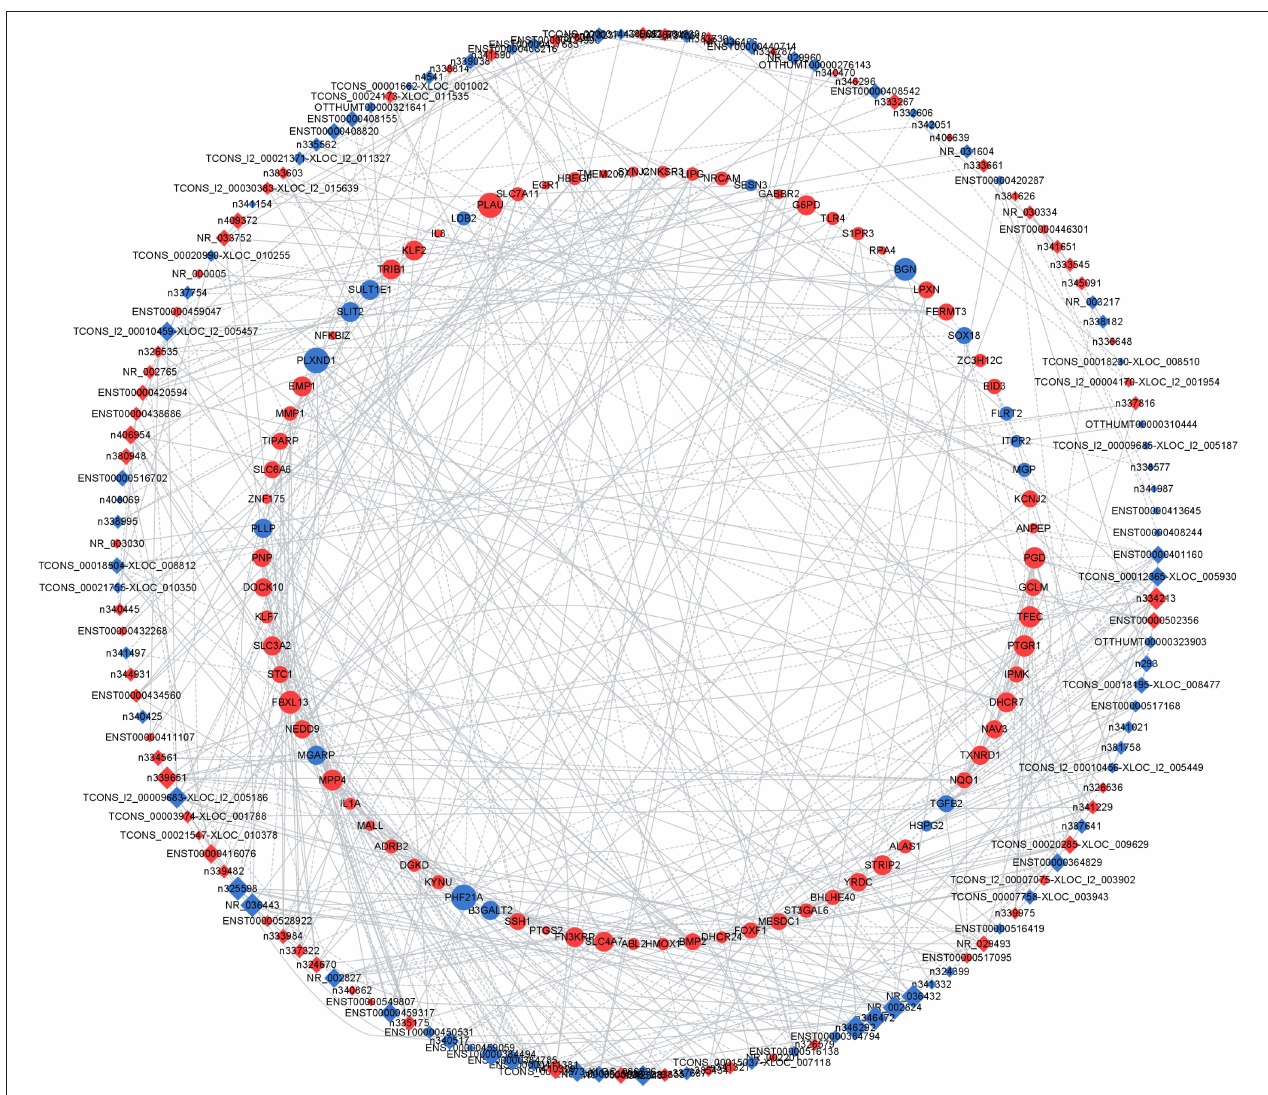
FIGURE 4 | Coexpression network of 149 DELs and 82 interacting DEGs. The diamonds represent lncRNAs; the circles represent their correlated mRNAs. Blue dots and red dots indicate downregulated and upregulated lncRNAs or mRNAs, respectively. Circle size indicates the node